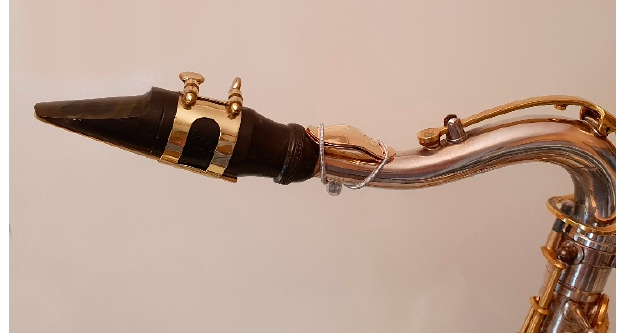
Figure 1. Picture of the upper part of a tenor saxophone with a “Gold-plated sound bridge” mounted to the connection-point of mouthpiece and S-bow according to the instructions of the manufacturer of the sound bridge. Source of picture: lefreQue BV/Netherlands.